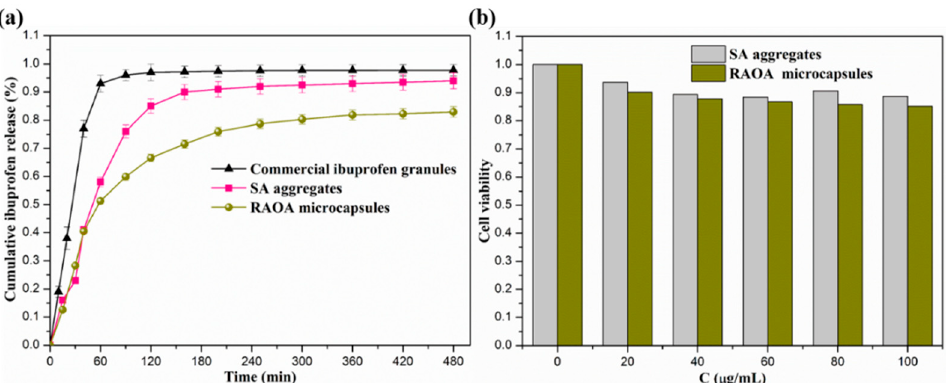
Figure 10. ( a ) CCK ‐ 8 assay for the cytotoxicity of RAW 264.7 cells cultured on the SA aggregates and the RAOA microcapsules after 2 days of incubation. ( b ) Release of ibuprofen from the commercial ibuprofen granules, SA aggregates, and RAOA microcapsules.